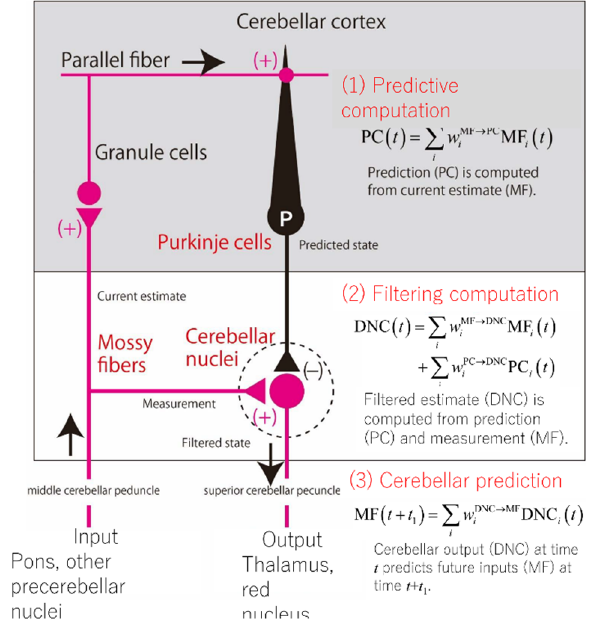
Figure 8. Schematics of the cerebellar circuit and corresponding computational steps. ( 1 ) Prediction computation. The PCs computes a predicted state from a current estimate conveyed by the mossy fibers (MFs). ( 2 ) Filtering computation. The predictive state computed by the PCs is integrated with an observation signal conveyed by other MFs for optimal estimation in DNCs. ( 3 ) Cerebellar prediction. The current output from the cerebellar circuit (DNCs) can predict future inputs to the cerebellum (MFs).